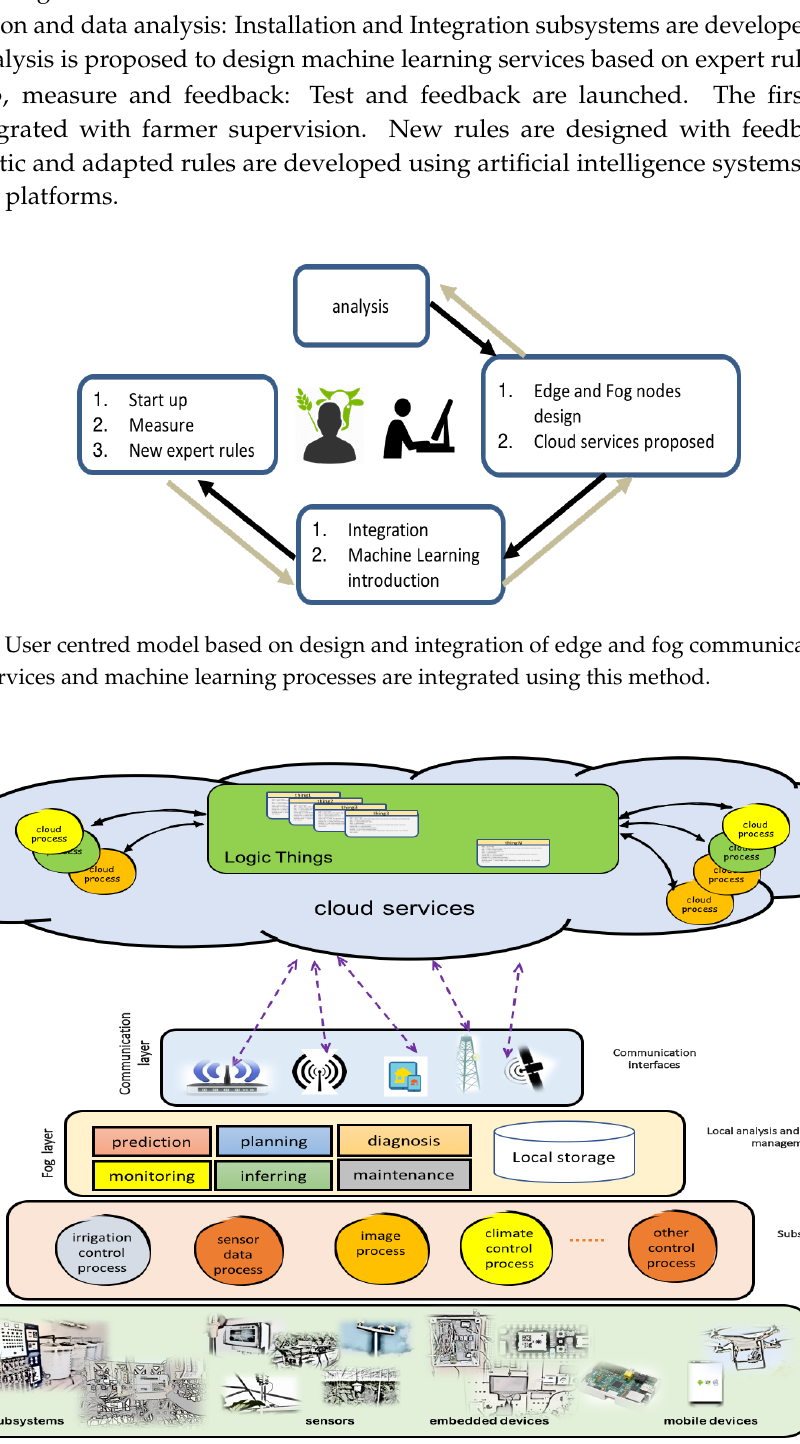
Figure 4. Architecture: communication levels with different